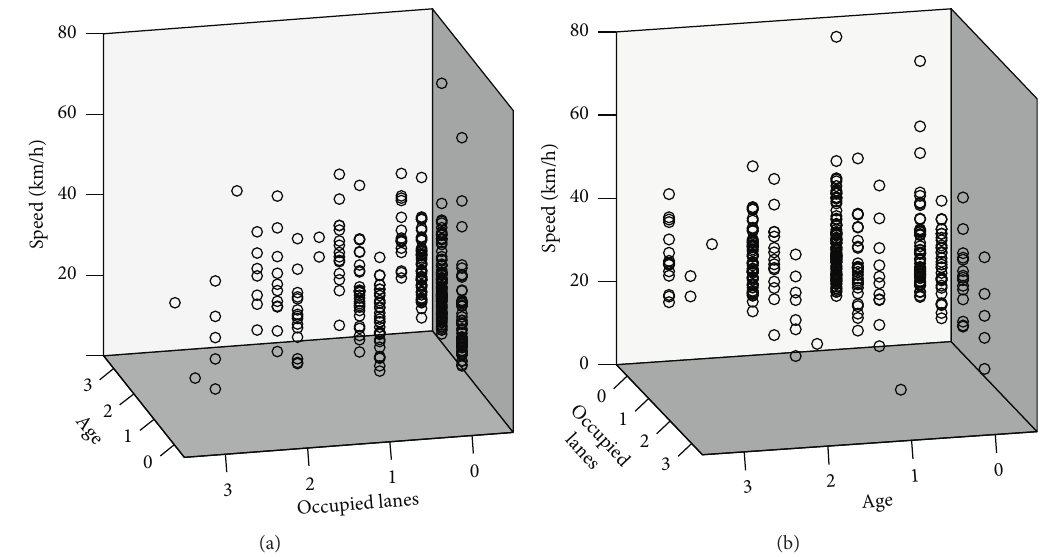
Figure 7: Relationship between age, traveling speed, and illegal lane occupation